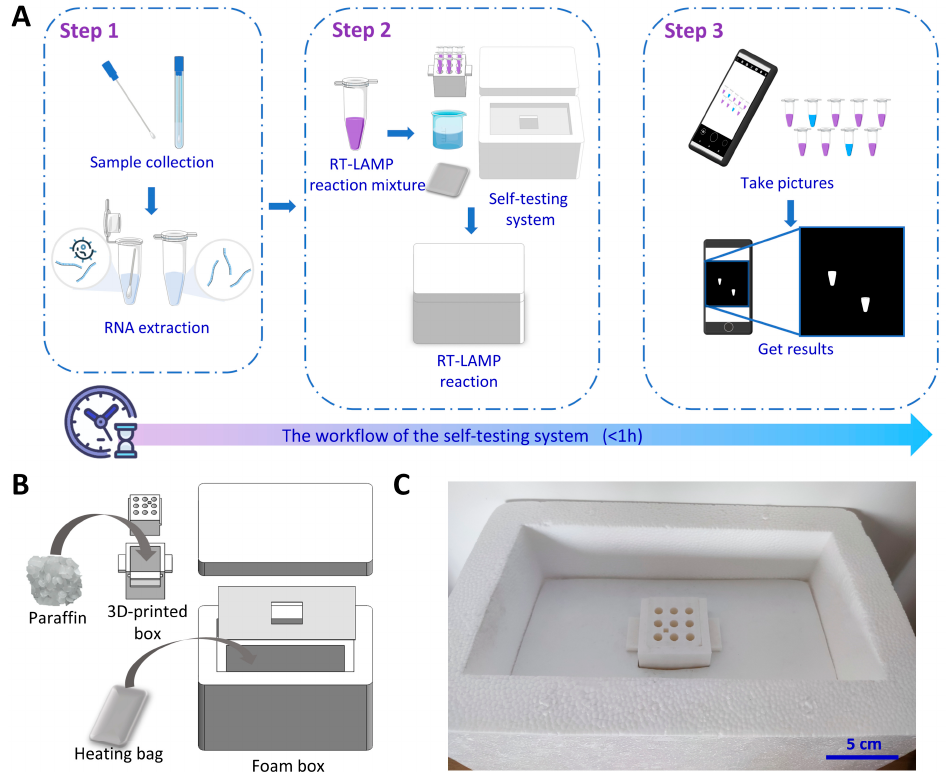
Figure 1. Detection of SARS-CoV-2 with the self-testing system. ( A ) Workflow of detection of SARS-CoV-2 with the self-testing system. The detection process using this self-testing system includes three steps: RNA preparation, RT-LAMP reaction, and data processing. ( B ) Schematic of incubation system. The system consists of a foam box, a heating bag, and a 3D-printed box. ( C ) Photograph of the incubation system.